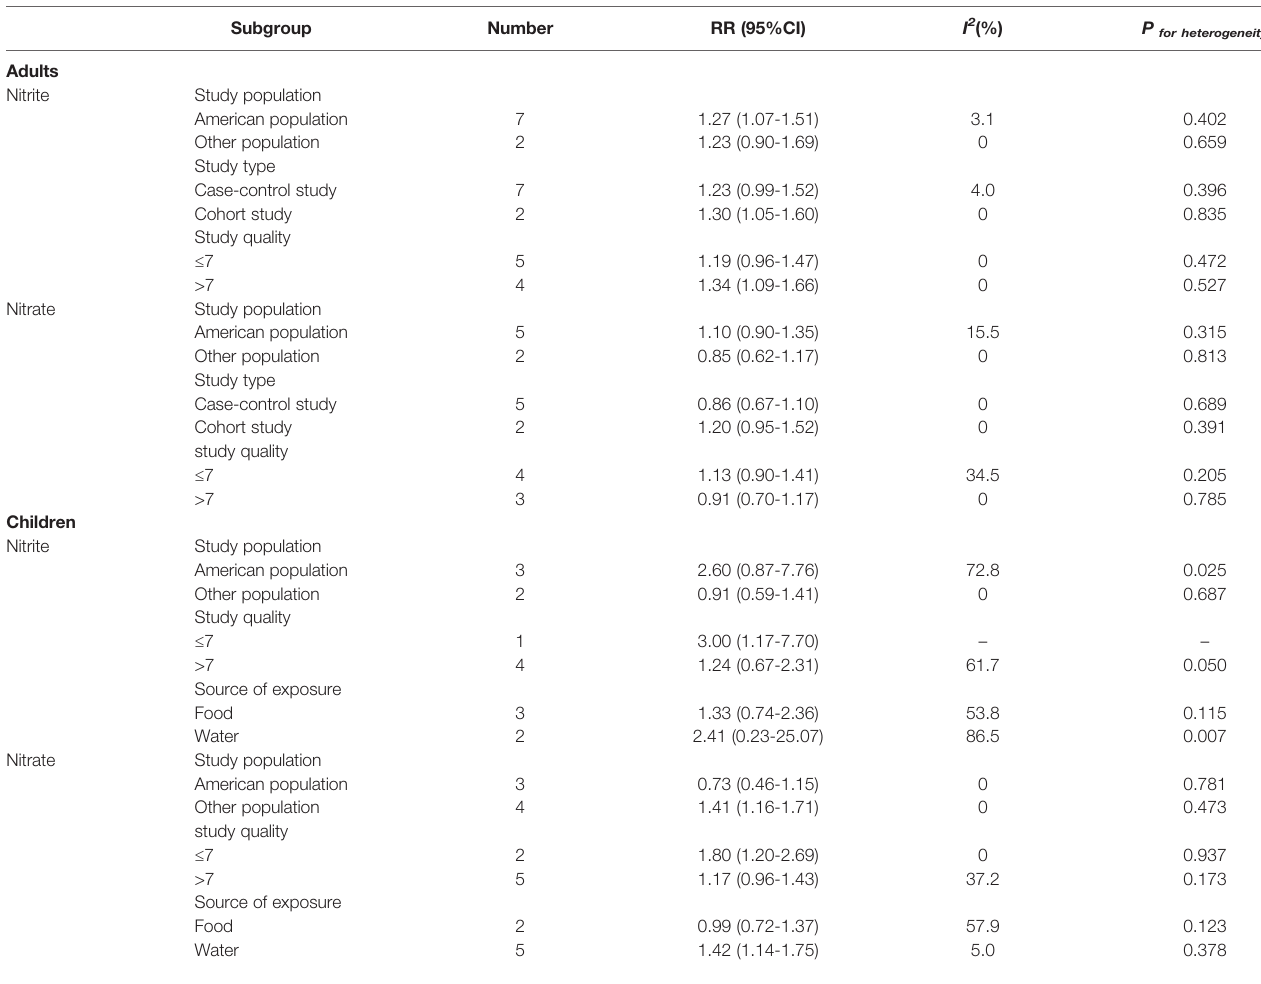
TABLE 3 | Subgroup analysis for the association between nitrite/nitrate and glioma. Subgroup Number RR (95%CI) I 2 (%) P for heterogeneity Adults Nitrite